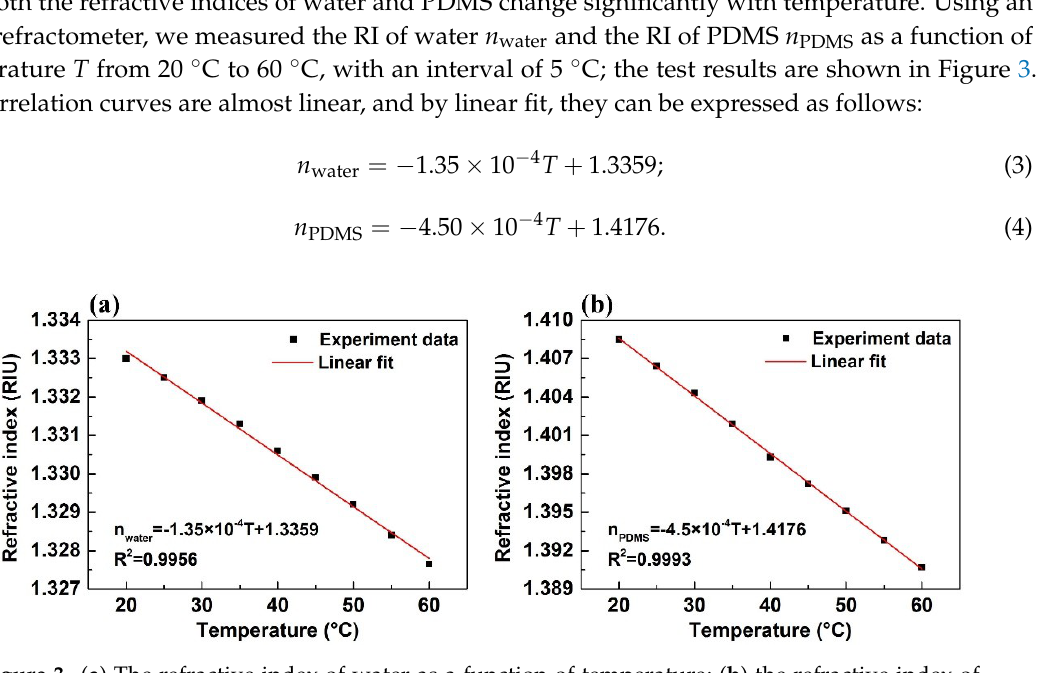
Figure 3. ( a ) The refractive index of water as a function of temperature; ( b ) the refractive index of polydimethylsiloxane (PDMS) as the function of temperature.